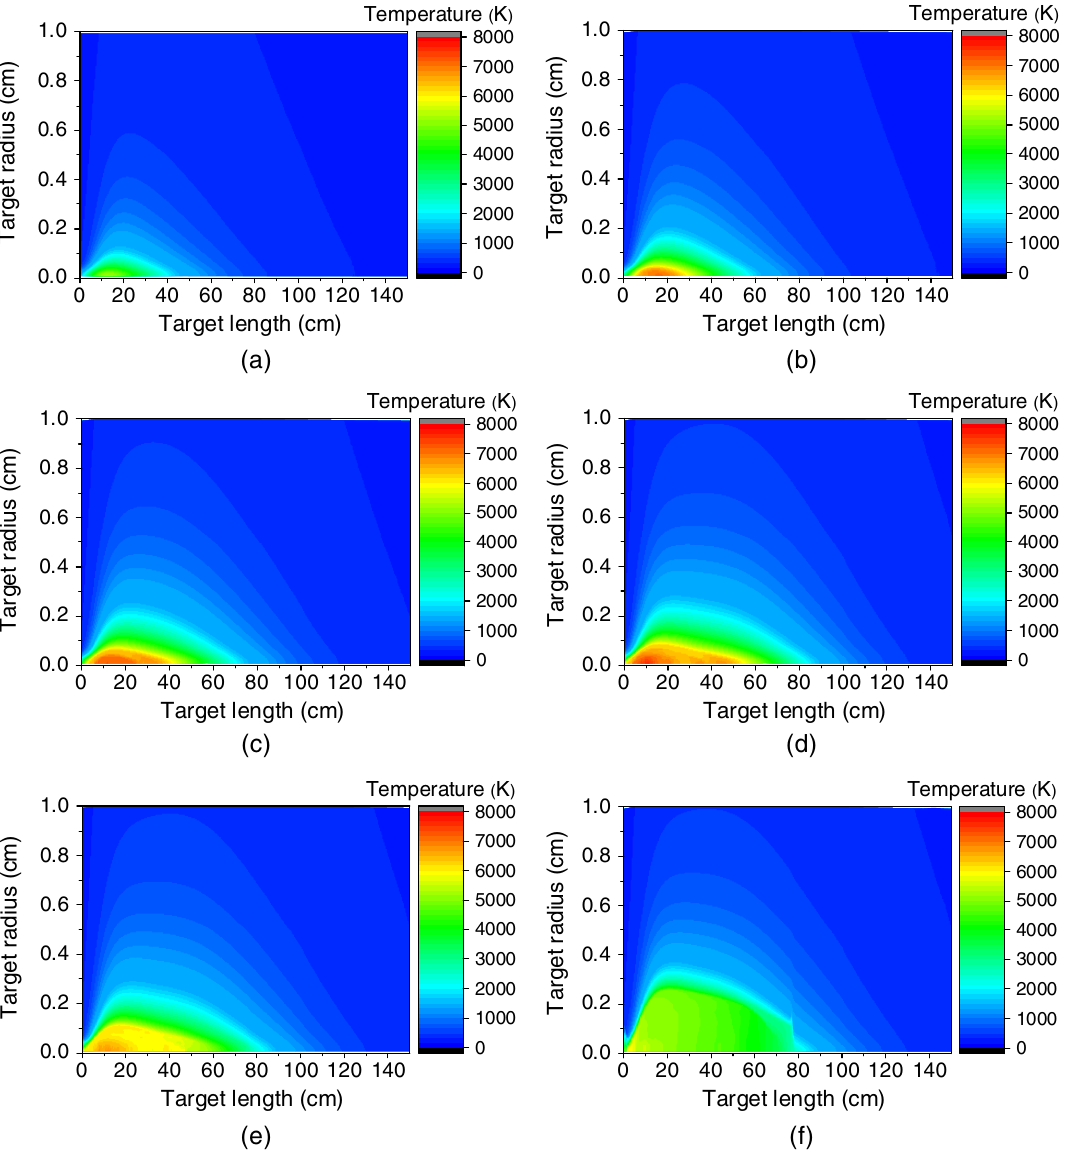
FIG. 6. Two-dimensional distributions of temperature in the r - z plane calculated by Autodyn (a) at t ¼ 1 . 8 μ s, after 36 bunches have been delivered, (b) at t ¼ 3 . 8 μ s, after 72 bunches, (c) at t ¼ 5 . 8 μ s, after 108 bunches, (d) at t ¼ 7 . 8 μ s, after 144 bunches, (e) at t ¼ 10 μ s, 2 . 2 μ s after the delivery of the beam, and (f) at t ¼ 20 μ s, 12 . 2 μ s after the delivery of the